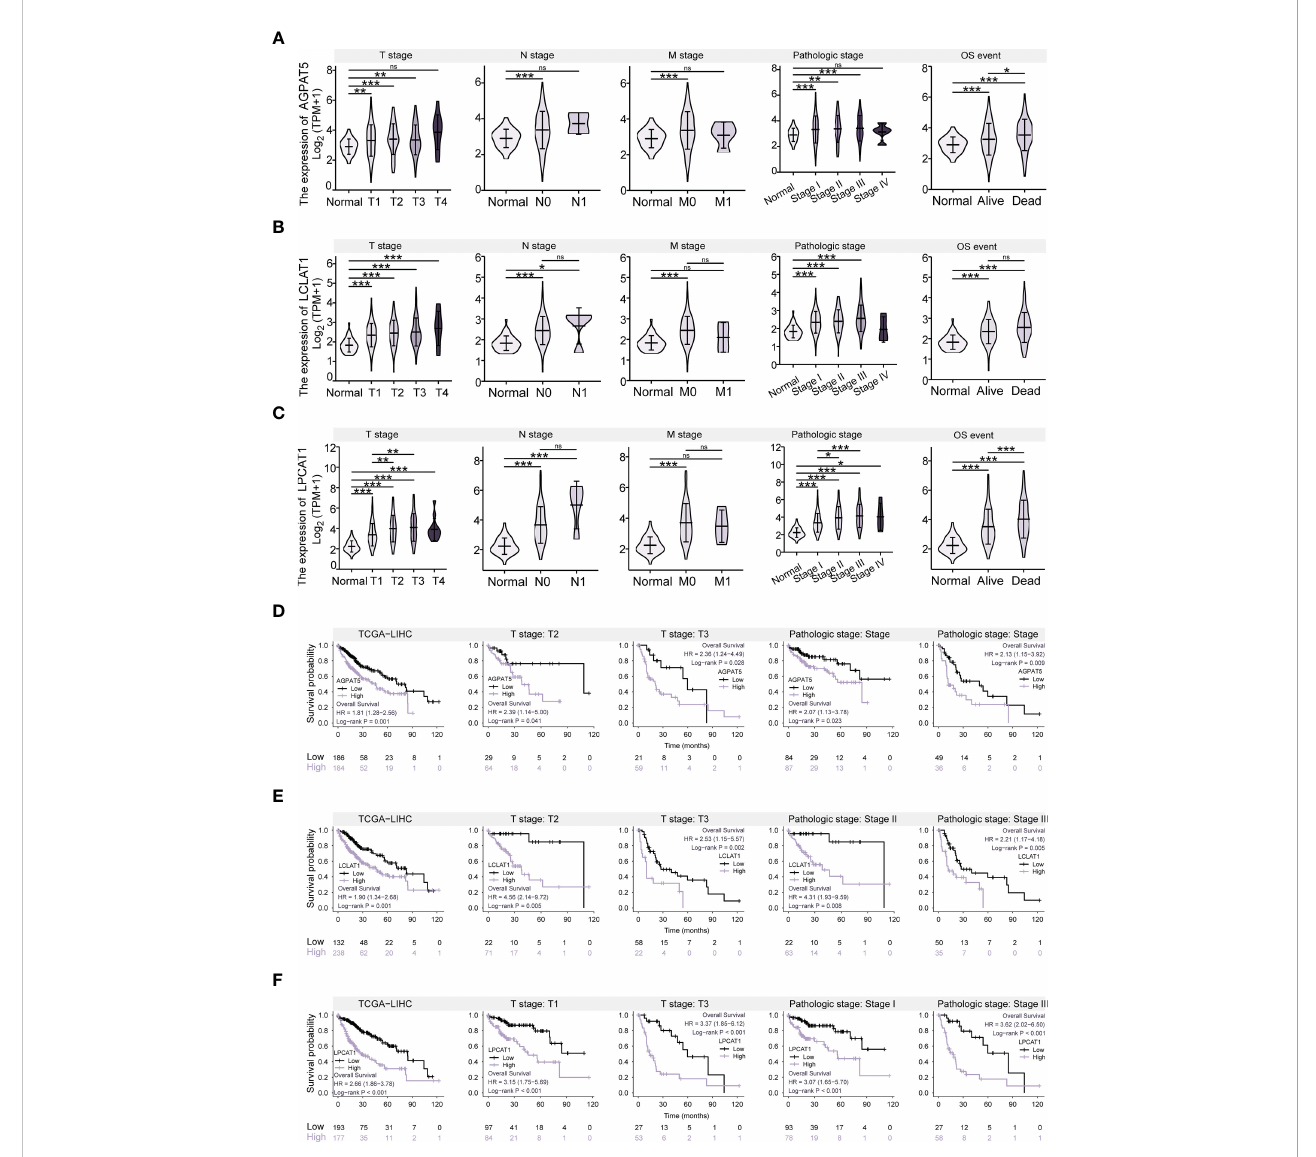
FIGURE 5 Relationship between Gene Expression and Clinical Characteristics, and Kaplan-Meier Survival Analysis. (A) Expression of AGPAT5 gene in different TNM stages, pathological stages, and survival subgroups compared with that in normal samples. (B) Expression of LCLAT1 gene in different TNM stages, pathological stages, and survival subgroups compared with that in normal samples. (C) Expression of LPCAT1 gene in different TNM stages, pathological stages, and survival subgroups compared with that in normal samples. (D) Survival curves for AGPAT5 high and low expression groups, for all patients, T2 stage, T3 stage, pathologic stage I, and pathologic stage III, respectively. (E) Survival curves for LCLAT1 high and low expression groups, for all patients, T2 stage, T3 stage, pathologic stage II, and pathologic stage III, respectively. (F) Survival curves for LPCAT1 high and low expression groups, for all patients, T1 stage, T3 stage, pathologic stage I, and pathologic stage III, respectively. Signi fi cance signs: ns, p ≥ 0.05; *p< 0.05; **p< 0.01; ***p<